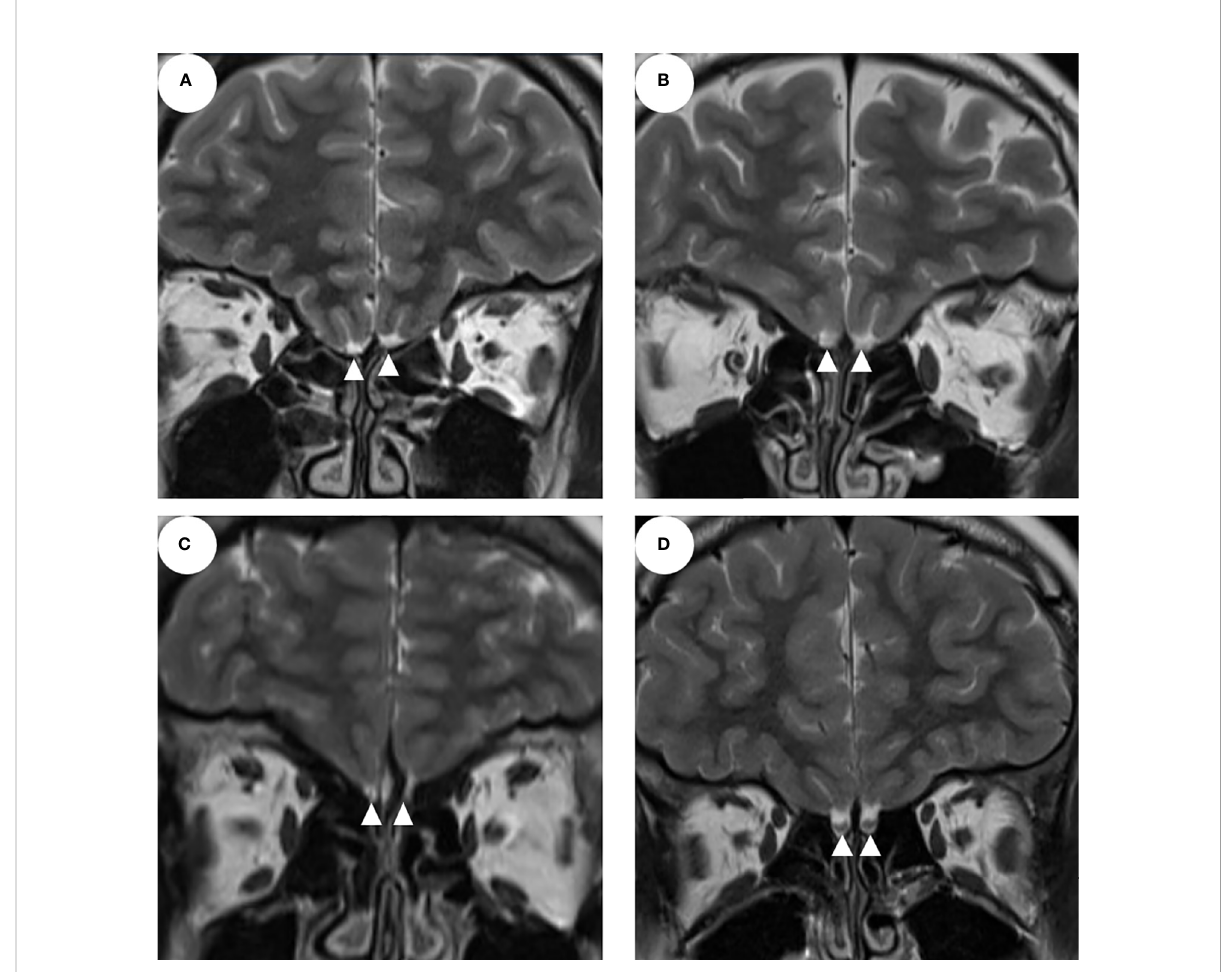
FIGURE 1 The MRI of the olfactory apparatus ( A – C show the bilateral olfactory bulb and/or sulcus aplasia; D shows normal olfactory bulbs and sulcus; the white triangles indicate the olfactory bulbs).